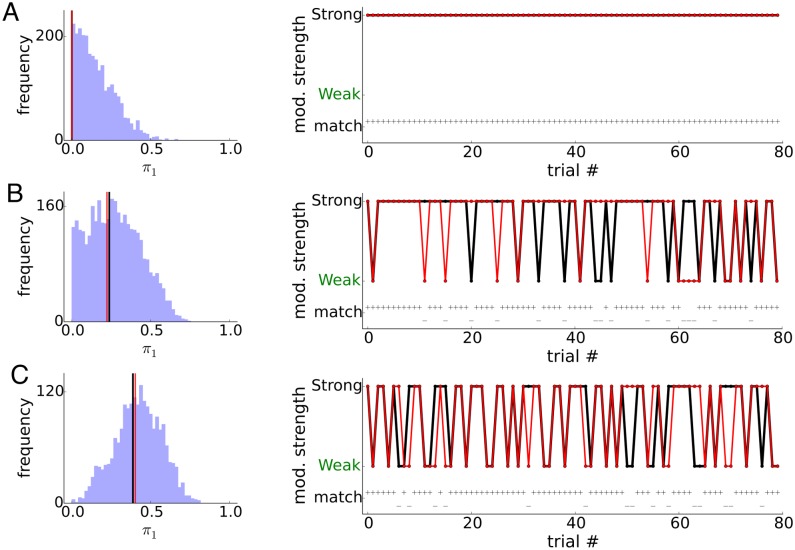
Mixture of modulated and non-modulated trials.A), B), C) 0%, 25% and 40% of the trials are weakly modulated. Left shows posterior distribution of π1 and the black line is the ground truth value, red line is the mode of the marginal posterior. Right shows inferred modulation state, weak or strong, for each of the 80 trials. Black dots are ground truth, red dots are inferred state. Below them are indicators (+−) of whether inferred matches ground truth.